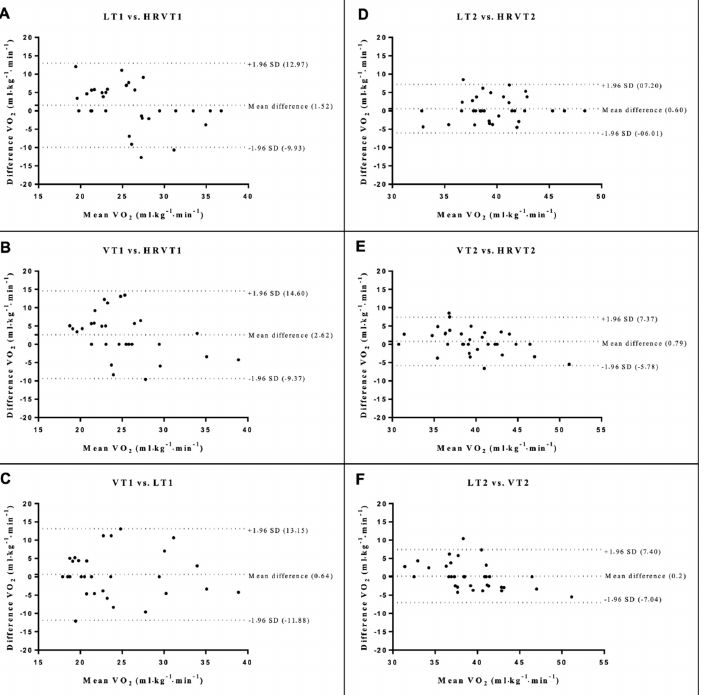
Figure 3. Bland Altman plots for V ̇ O 2 at thresholds 1 ( A – C ) and 2 ( D – F ). The dashed lines at the ends represent the limits of agreement (1.96 SD) and the dashed central lines (bias). Lactate threshold 1 (LT1), ventilatory threshold 1 (VT1), heart rate variability threshold 1 (HRVT1), lactate threshold 2 (LT2), ventilatory threshold 2 (VT2), heart rate variability threshold 2 (HRVT2). Int. J. Environ. Res. Public Health 2022 , 19 , x FOR PEER REVIEW